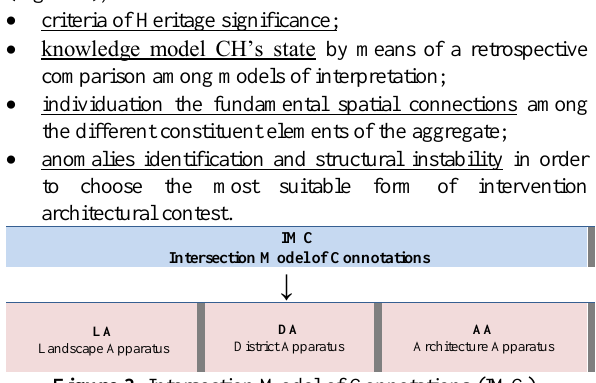
Figure 3. Intersection Model of Connotations